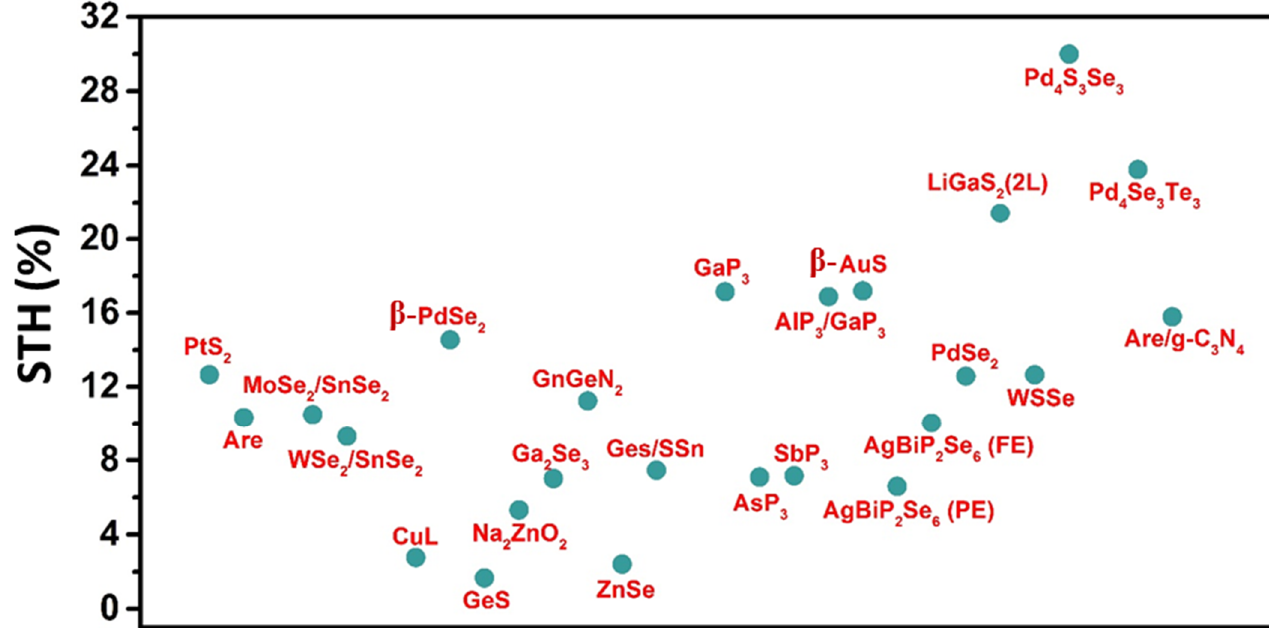
Figure 5. Solar-to-hydrogen (STH) efficiency for 2D materials.